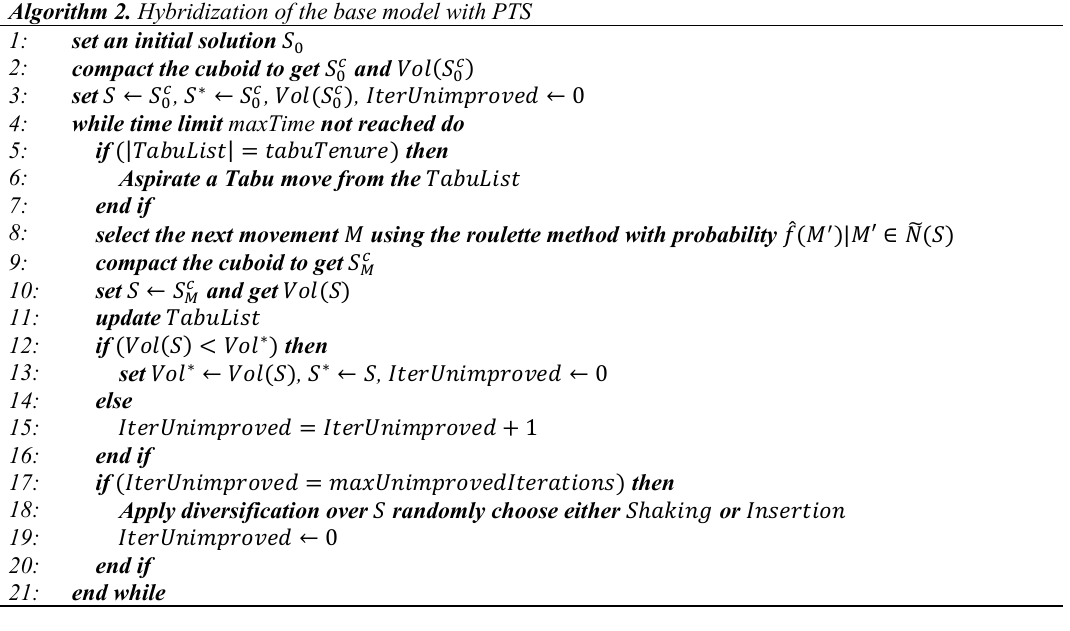
Algorithm 2. Hybridization of the base model with